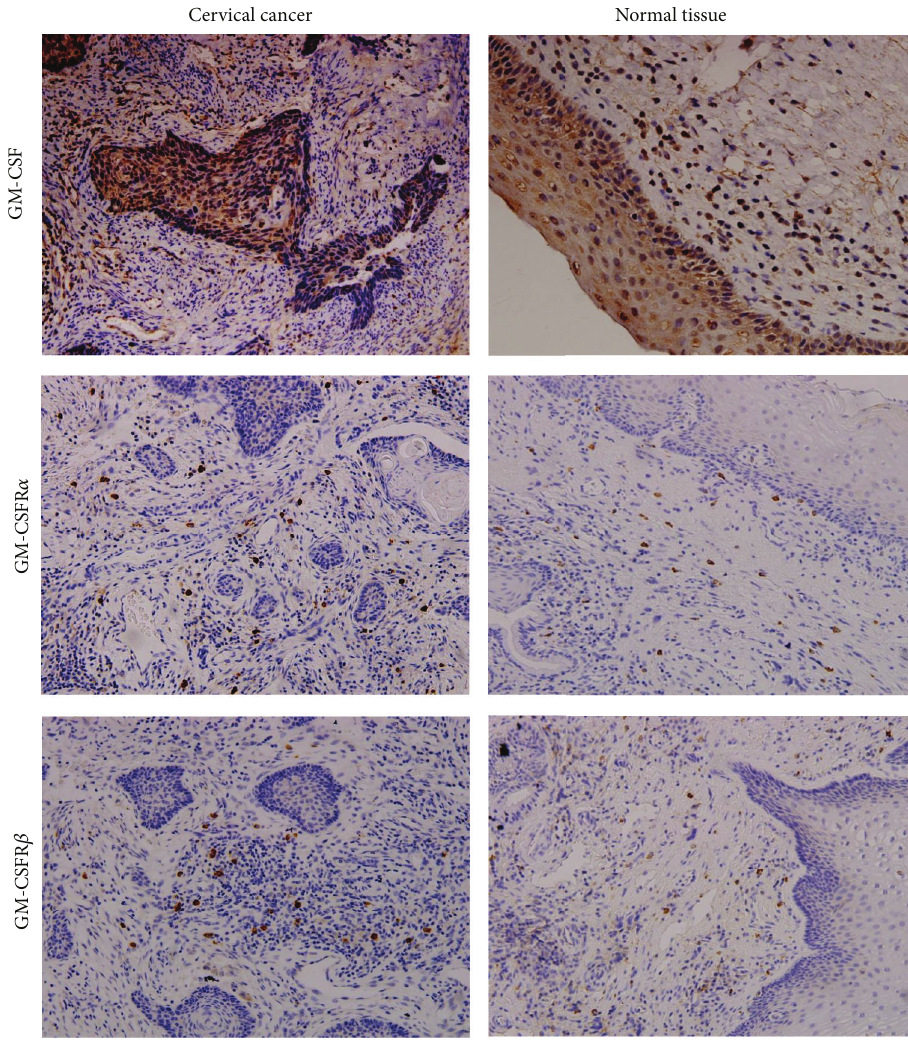
Figure 2: Expression of GM-CSF and GM-CSFR in cervical cancer tissues. Representative results of IHC assays showing the moderate/strong GM-CSF and GM-CSFR ( 𝛼 and 𝛽 chains) expression observed in the cervical cancer tissues and normal cervical tissues. Brown color indicates positive staining for the indicated